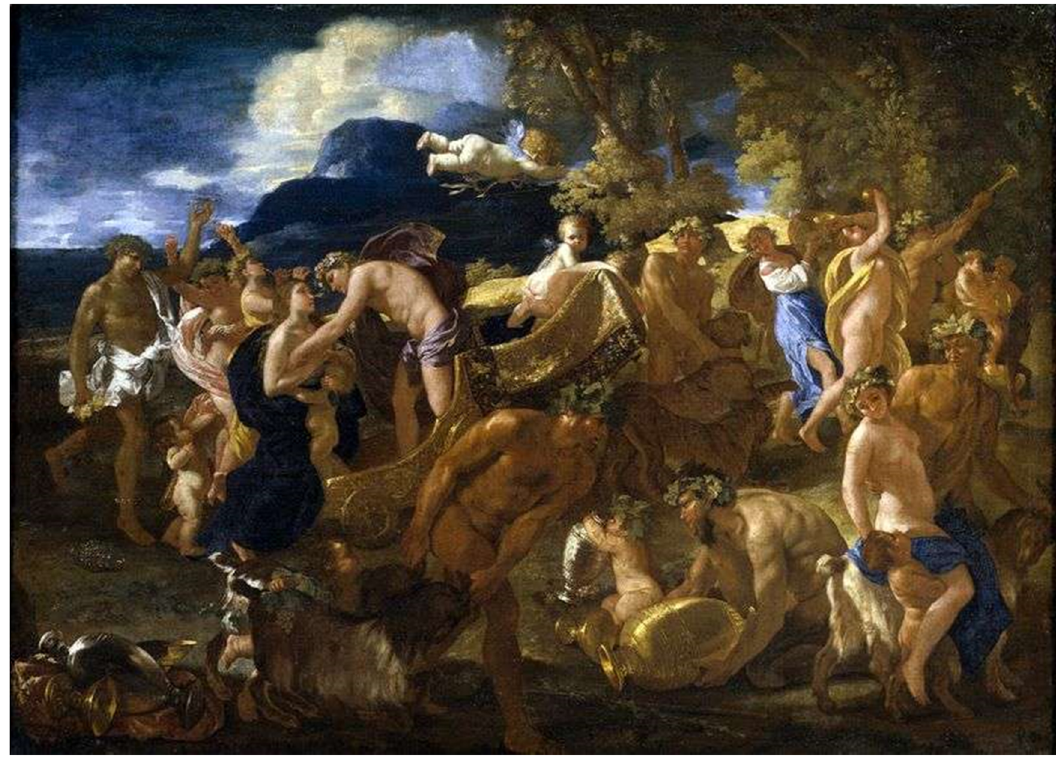
Figure 31: Nicolas Poussin, Bacchanale , 1626. Museo del Prado, Madrid. Public